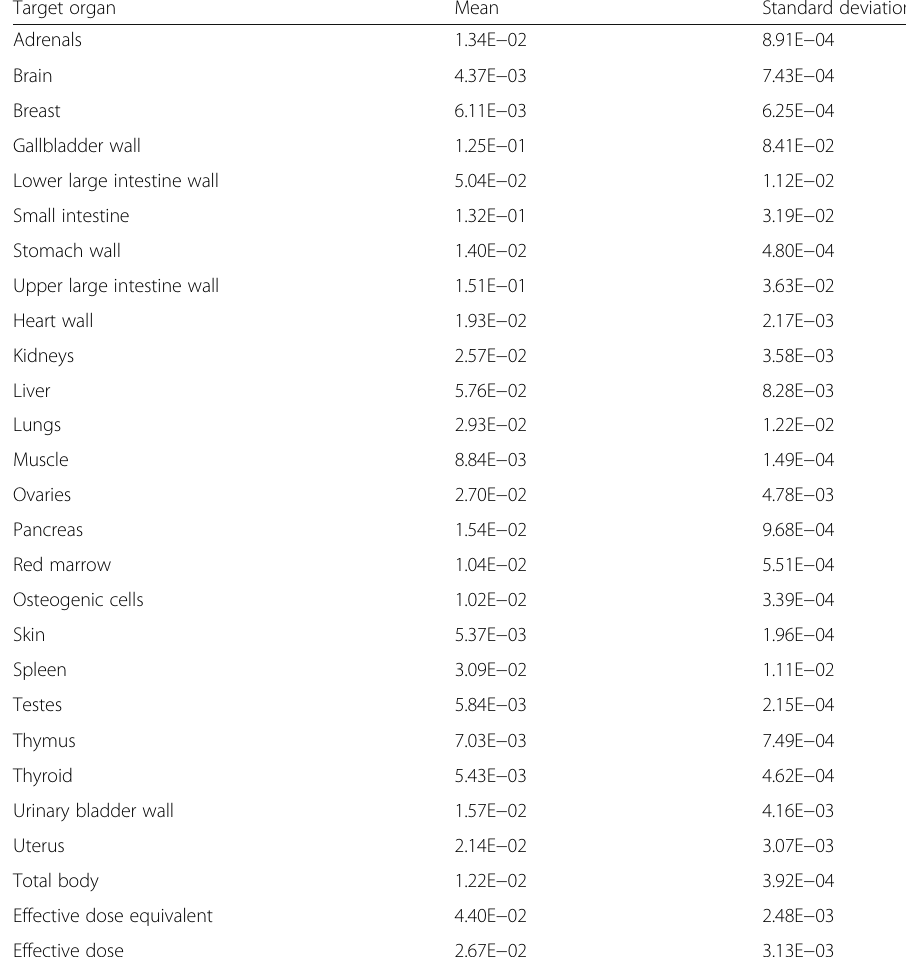
Table 2 Mean FTP radiation dose estimates for the intervention group (mSv/MBq, n = 4) Target